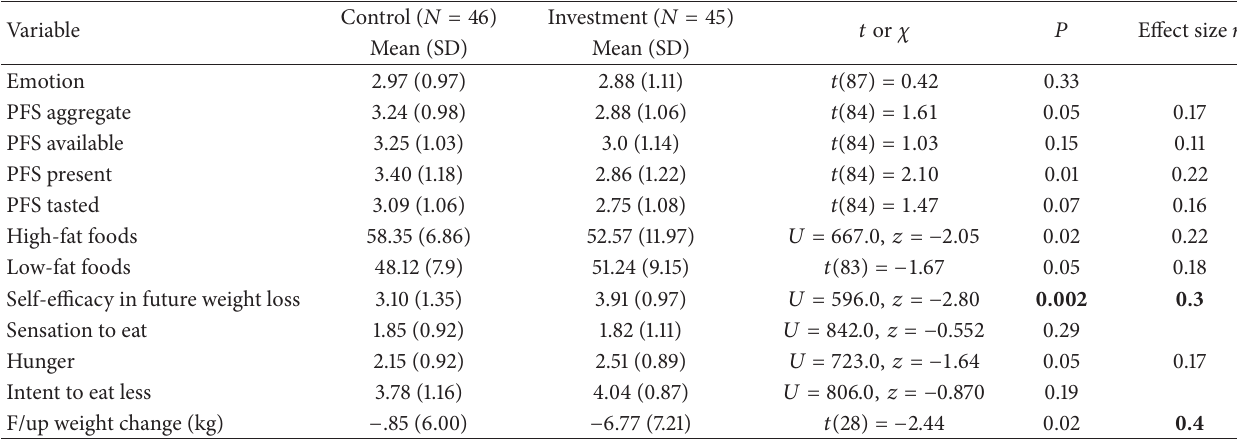
Table 2: Intervention effects on hedonic thoughts and weight